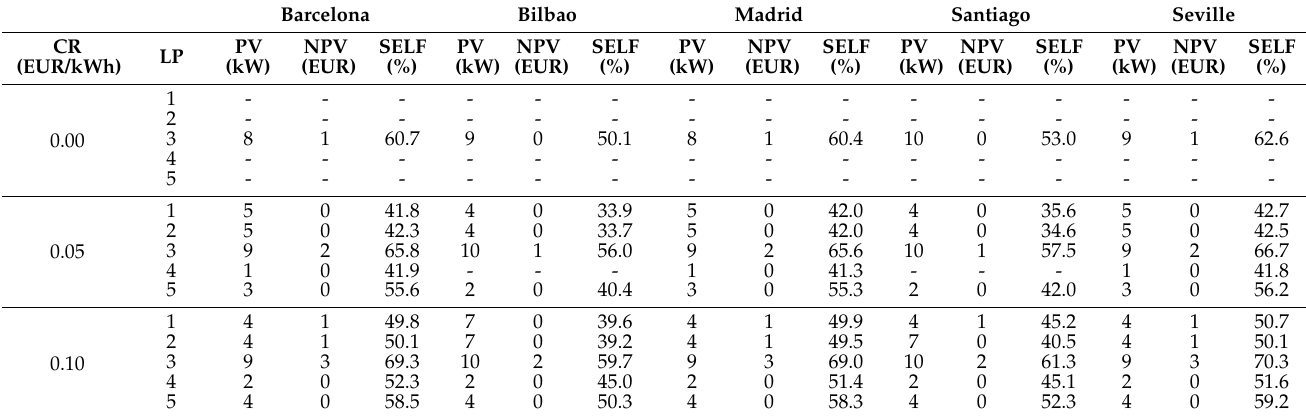
Table 4. Results of the computational experiment assuming self-sufficiency maximisation.